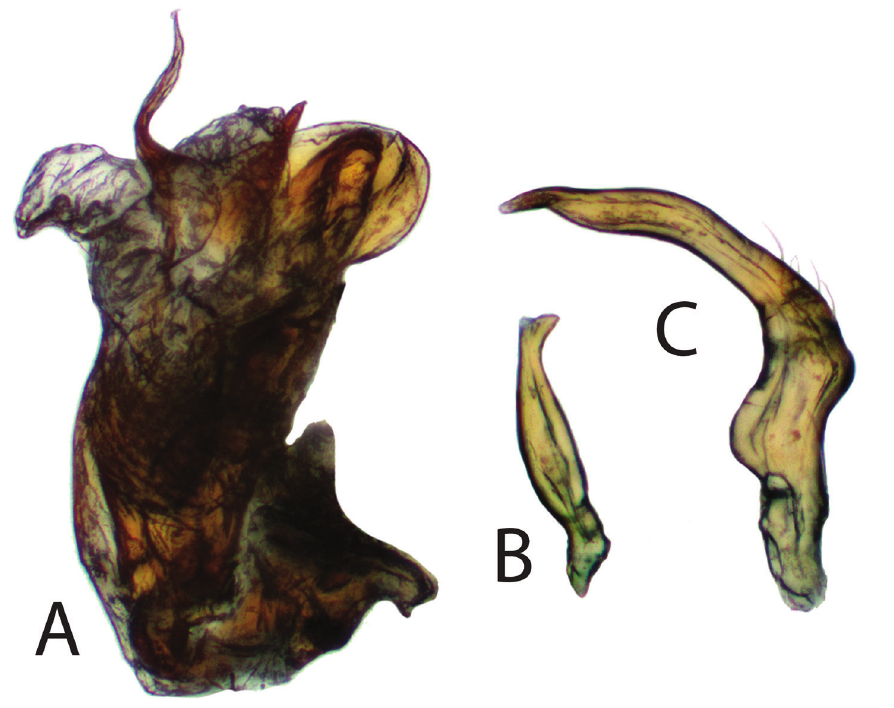
Figure 5. Male genitalia of Philicoris palali sp. n. showing A endosoma B right paramere, and C left paramere. Images taken at 100× using a compound light